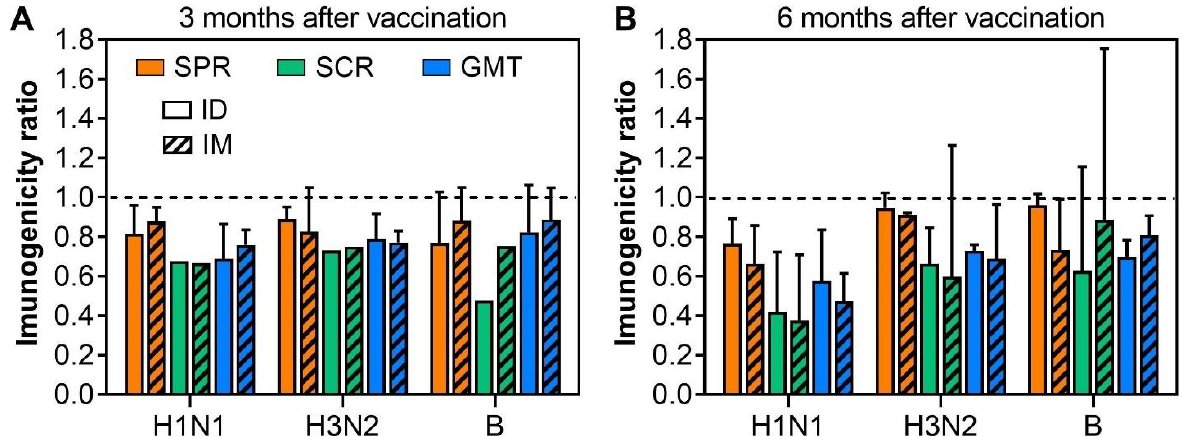
Figure 4. Comparison of the duration of influenza-specific immune responses at 3 ( A ) and 6 ( B ) months after vaccination in the elderly. The ratios of SPR, SCR, and GMT were calculated by dividing the mean SPR, SCR, GMT at 3 or 6 months by those at their peak of 21 – 28 days after the last immunization. A ratio of <1 (dash line) implies the waning of influenza-specific immune responses.